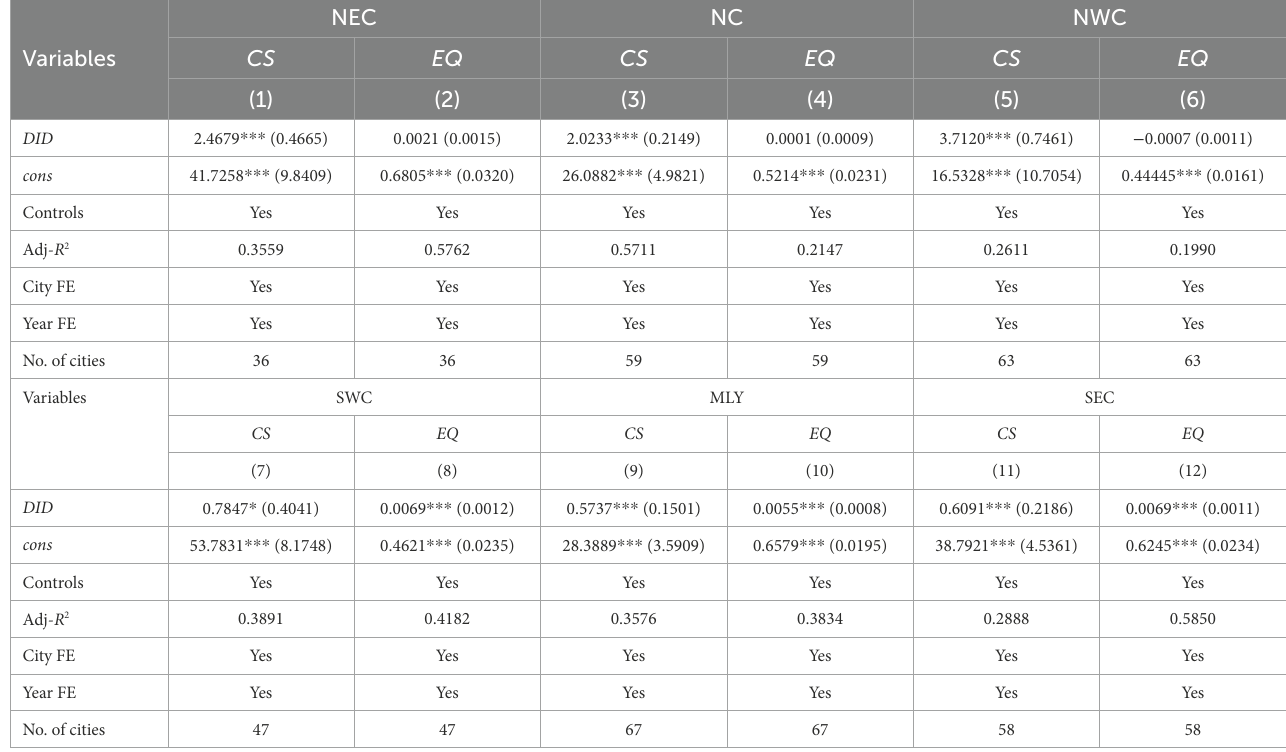
TABLE 6 Heterogeneity analysis: regional differences based on geographic space.